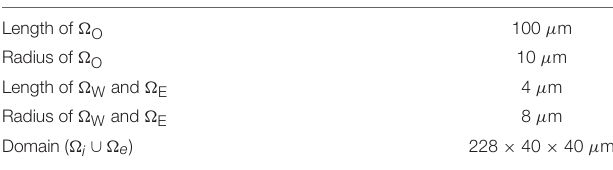
TABLE 10 | Cell and domain sizes used in the simulations of the two connected cylinders in Figure 6 .